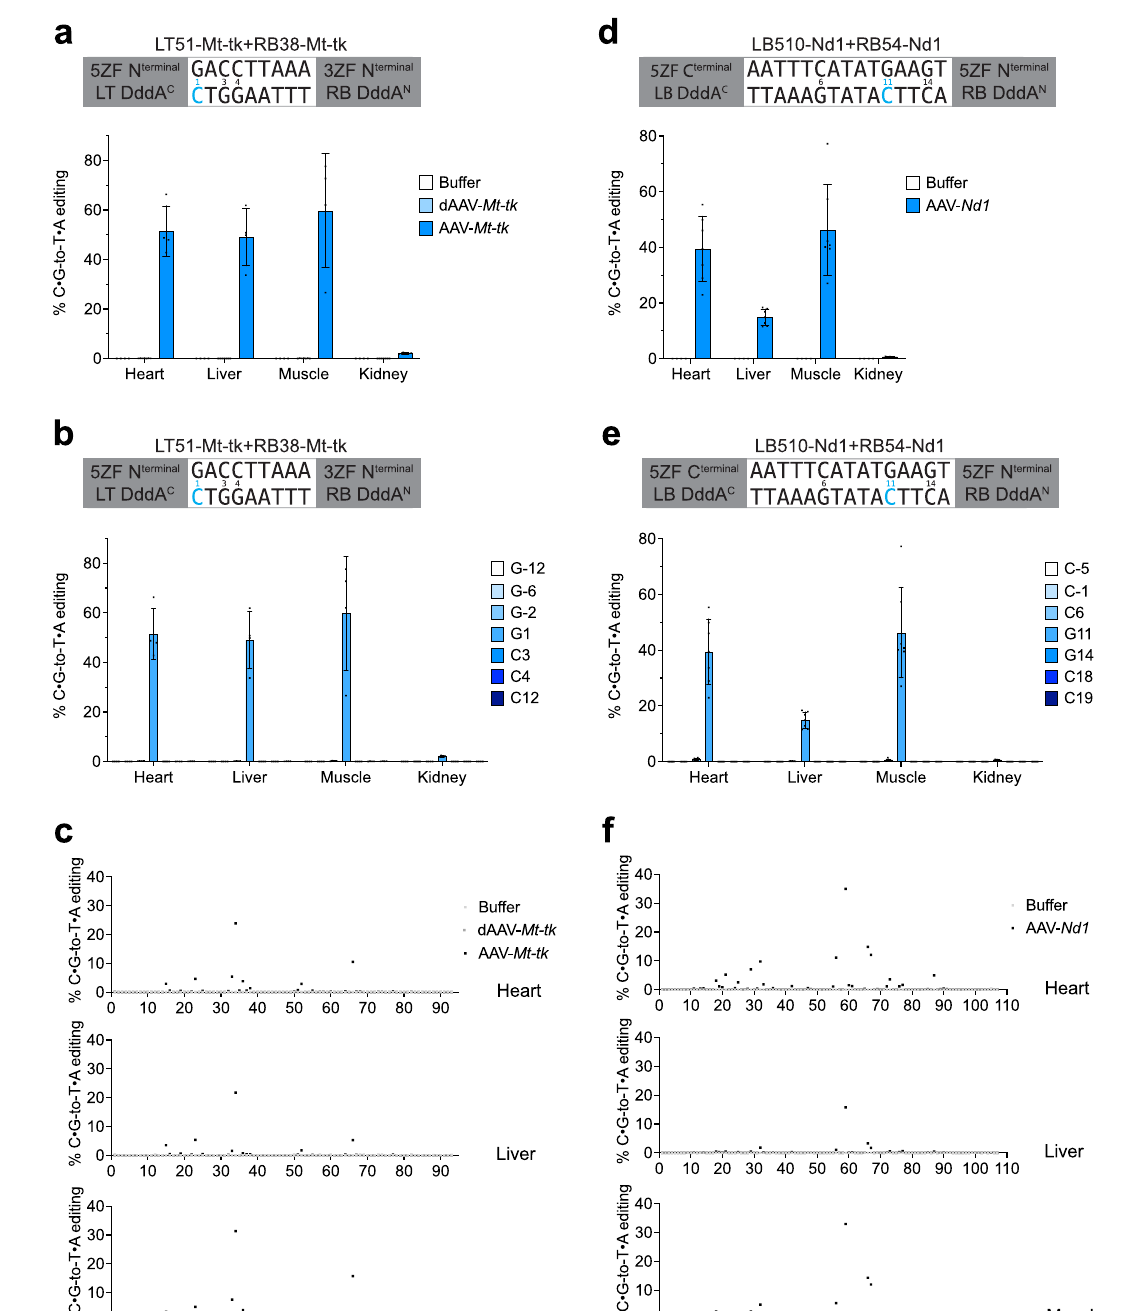
Fig. 6 | In vivo base editing ofpathogenic sites in mtDNA. a Mitochondrial DNA base editing ef fi ciencies installing m.7743G>A of tissue samples from mice treated with buffer, dAAV- Mt-tk , or AAV- Mt-tk . b Mitochondrial DNA base editing ef fi - ciencies of tissue samples from AAV- Mt-tk -treated mice. c Off-target editing ef fi - ciencies within representative mitochondrial off-target amplicon OT8 of tissue samples from mice treated with buffer, dAAV- Mt-tk , or AAV- Mt-tk . d Mitochondrial DNA base editing ef fi ciencies installing m.3177G>A of tissue samples from mice treated with buffer or AAV- Nd1 . e Mitochondrial DNA base editing ef fi ciencies of tissue samples from AAV- Nd1 -treated mice. f Off-target editing ef fi ciencies within